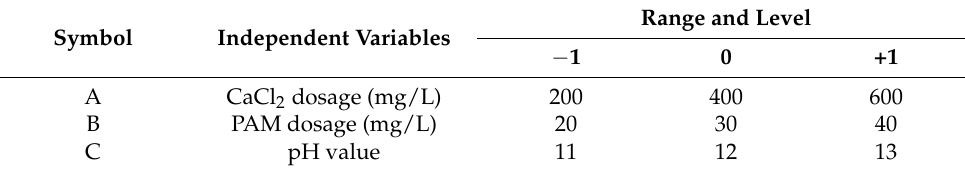
Table 1. Range and level of the independent variables.